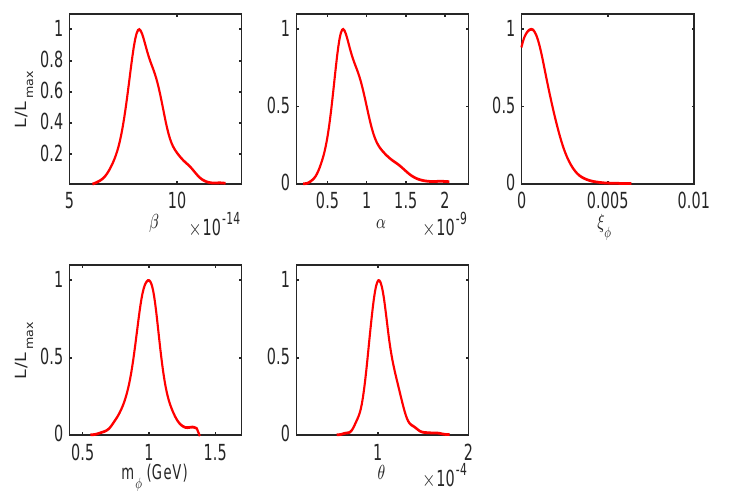
Figure 4. Marginalised likelihood probability distributions of the dark Higgs parameters from the fit of the dark Higgs inflation model with curvature corrections with the P LANCK TT, TE, EE + lowE + lensing + BK15